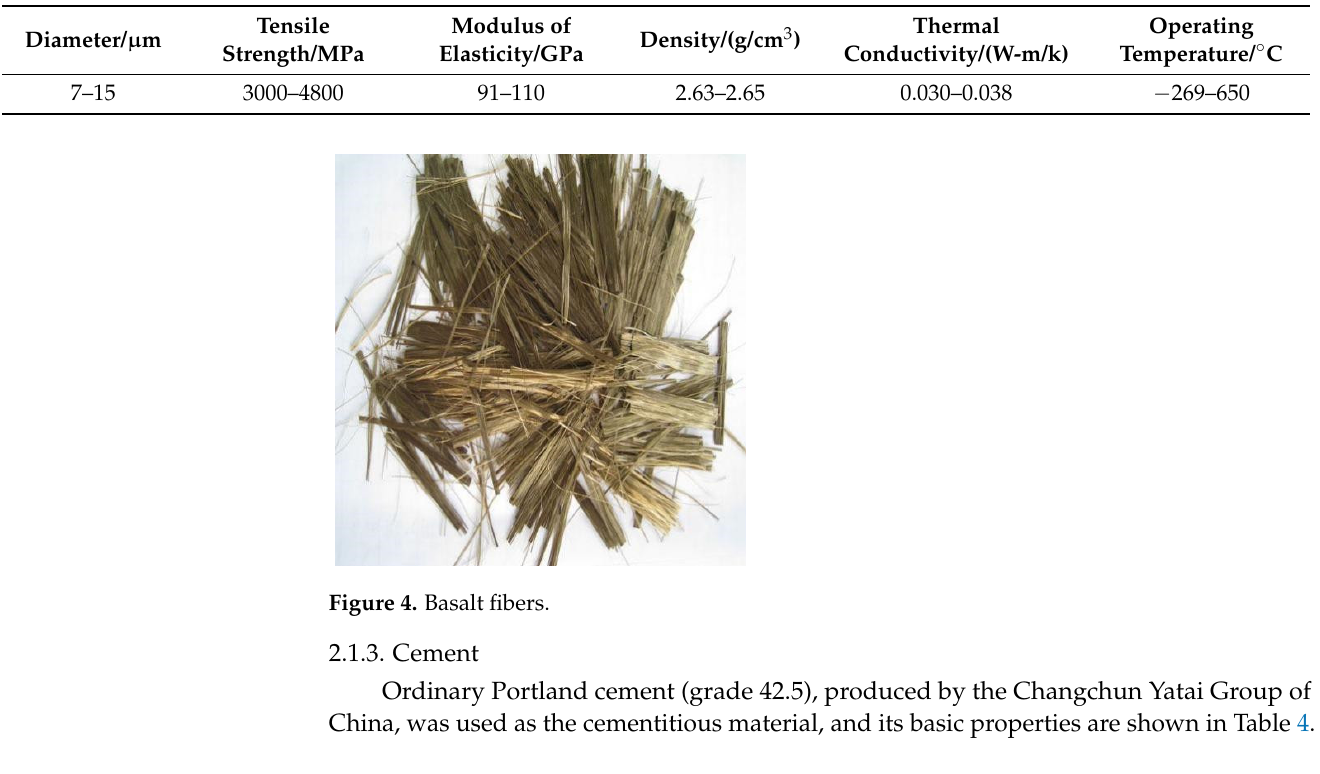
Table 4. Basic properties of the